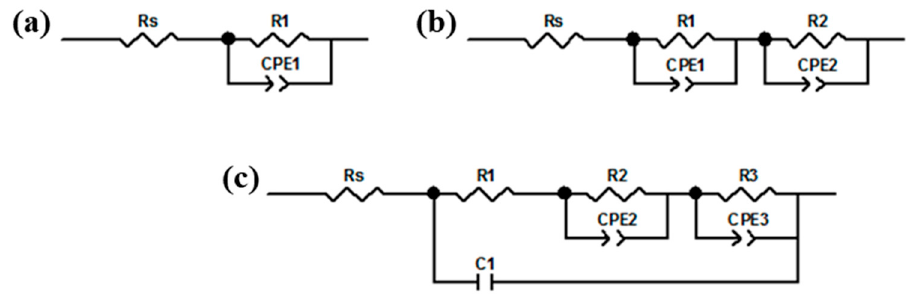
Figure 12. Equivalent circuits of ( a ) Colmonoy, ( b ) Inconel, and ( c ) Al coatings at 50 °C.